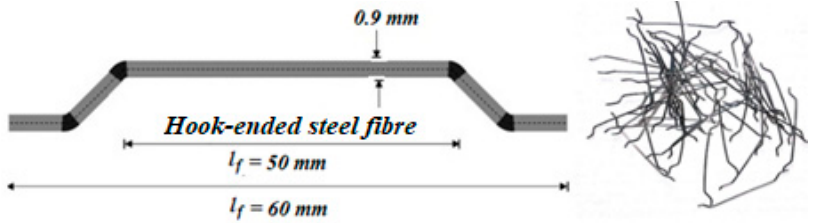
Figure 8. Type and dimension of the SFs used in this study.